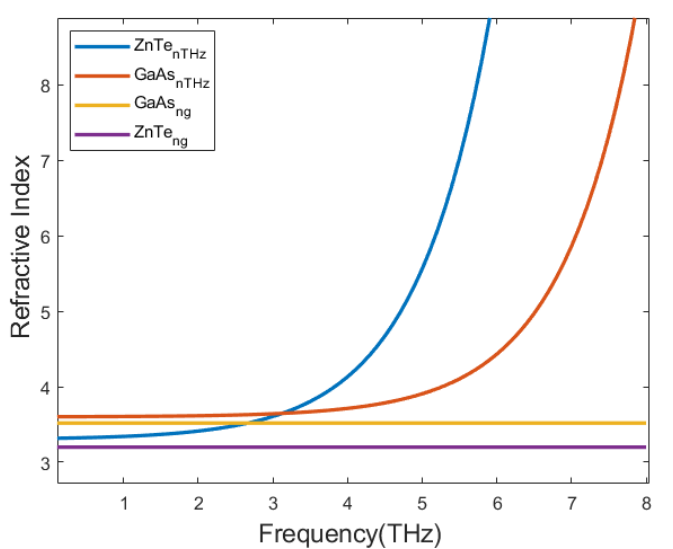
Figure 5. THz refractive index and group refractive index of the GaAs and the ZnTe crystals.